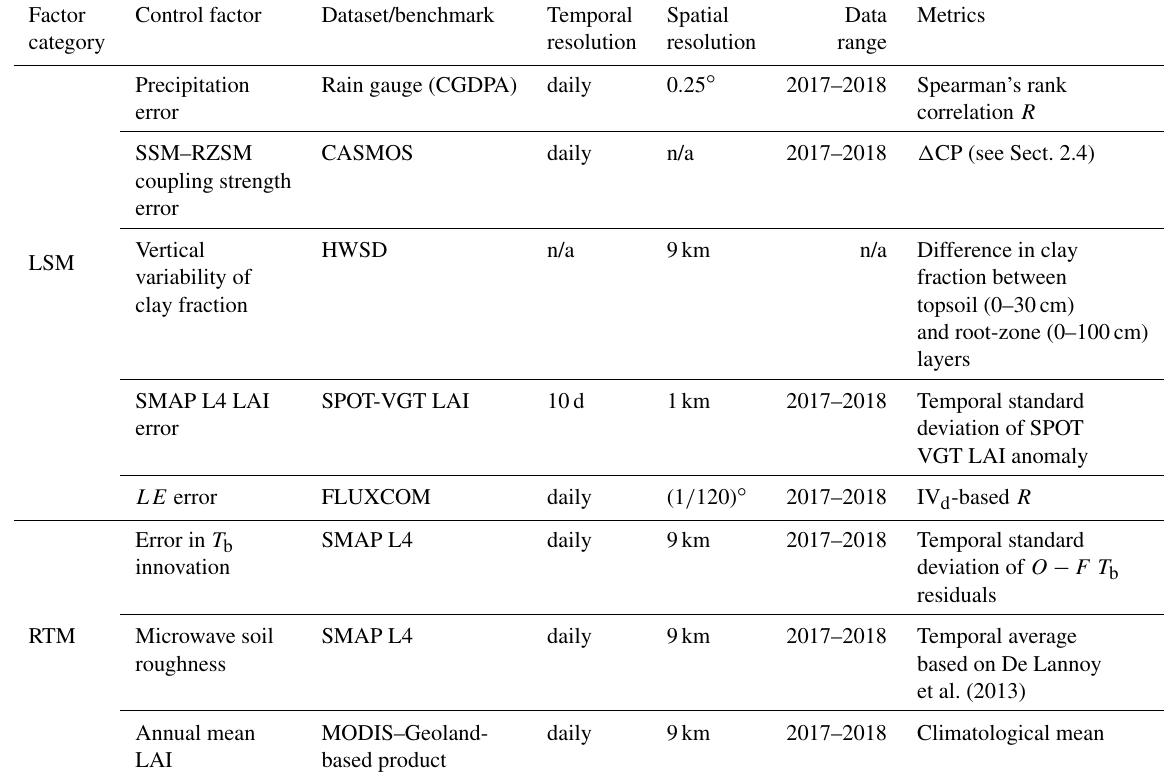
Table 1. Benchmark datasets and metrics used for evaluating control factors of SMAP